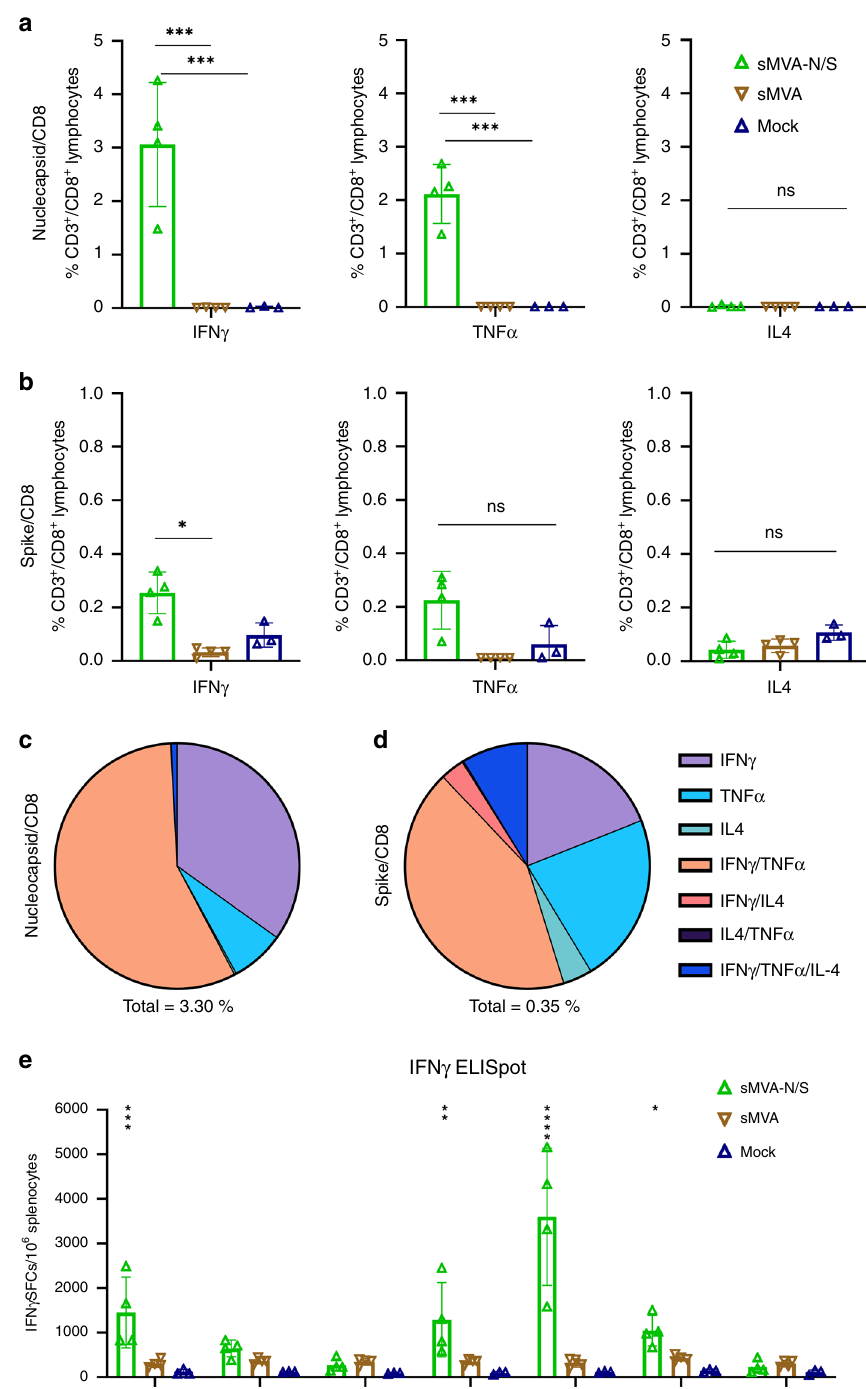
Fig. 7 CD8 + T-cell responses induced by sMVA-N/S in HLA transgenic mice. HLA-B*07:02 (B7) transgenic mice ( n = 4) were immunized twice in a 3- week interval with 1 × 10 7 PFU of sMVA-N/S or sMVA control vector (reconstituted with FPV TROVAC). B7 mice ( n = 3) were mock-immunized as additional control. Development of SARS-CoV-2-speci fi c CD8 + T cells was evaluated 1 week post booster immunization. a – d Intracellular cytokine staining. Nucleocapsid- ( a , c ) and Spike-speci fi c ( b , d ) CD8 + T cells were evaluated by intracellular cytokine staining for IFN γ , TNF α , and IL-4 secretion following ex vivo antigen stimulation by N and S peptide libraries, respectively. Panels a and b show the percentage of CD3 + /CD8 + T cells secreting IFN γ , TNF α , or IL-4 following peptide stimulation. Panels c and d show relative frequencies of CD8 + T cells secreting one or more cytokines after peptide stimulation. Total percentage of cytokine-secreting cells within CD3 + /CD8 + population is indicated under each pie chart. e ELISPOT analysis of IFN γ - secreting cells following stimulation with S and N peptide libraries, S library sub-pools (1S1, 2S1, S2), and N26 peptide containing the HLA-B*07:02- restricted N-speci fi c immunodominant epitope SPRWYFYYL. One-way ANOVA with Dunnett ’ s multiple comparison test was used in a and b . Two-way ANOVA with Dunnett ’ s multiple comparison test was used in e . Data in a , b , and e are presented as mean values ± SD; *0.05 < p < 0.01, **0.01 < p <